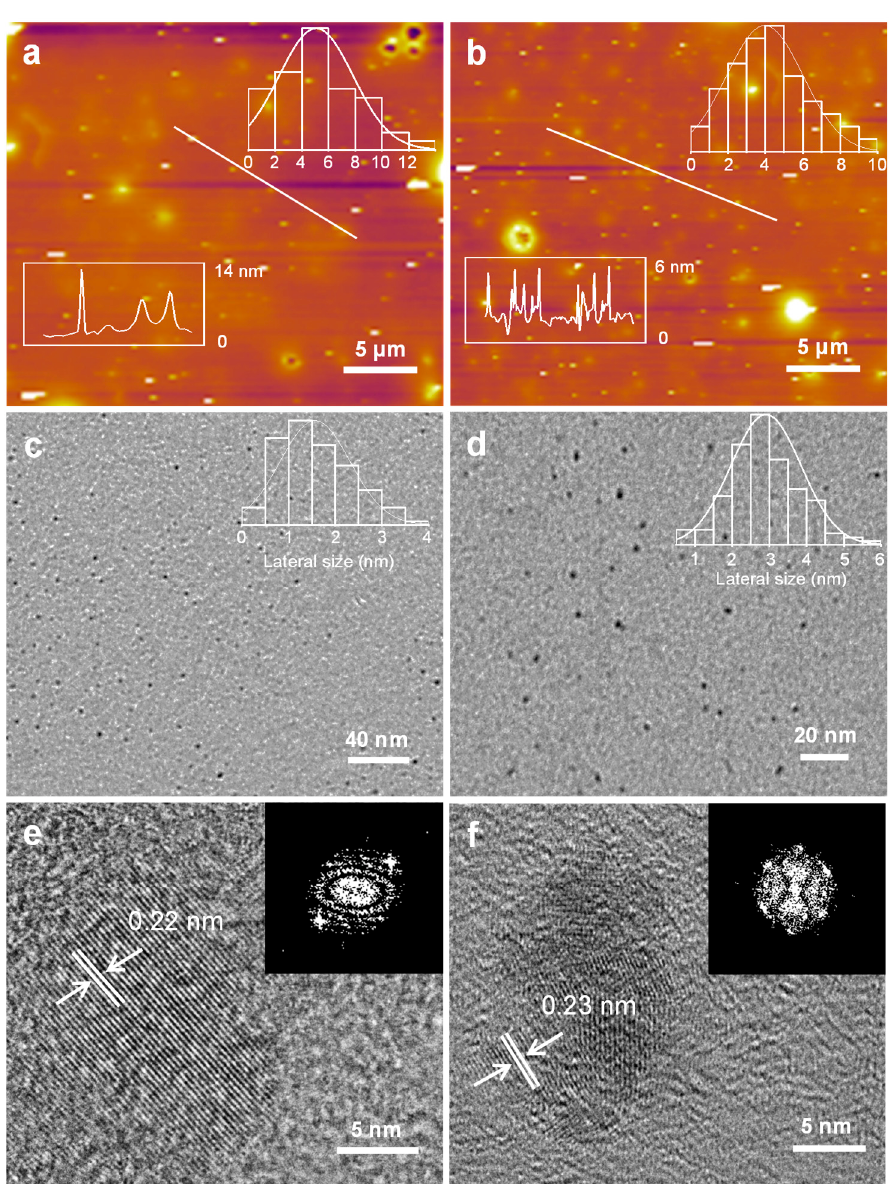
Figure 1. AFM images and height distributions of GQDs ( a ) and N − GQDs ( b ) (the inset is the thickness line chart and thickness distribution histogram of GQDs and N − GQDs). The TEM images and relative size distribution of GQDs ( c ) and N − GQDs ( d ) (the inset shows the particle size distribution histograms of GQDs and N − GQDs). The high-resolution TEM images of GQDs ( e ) and N − GQDs ( f ) (insets: fast Fourier transform pattern).